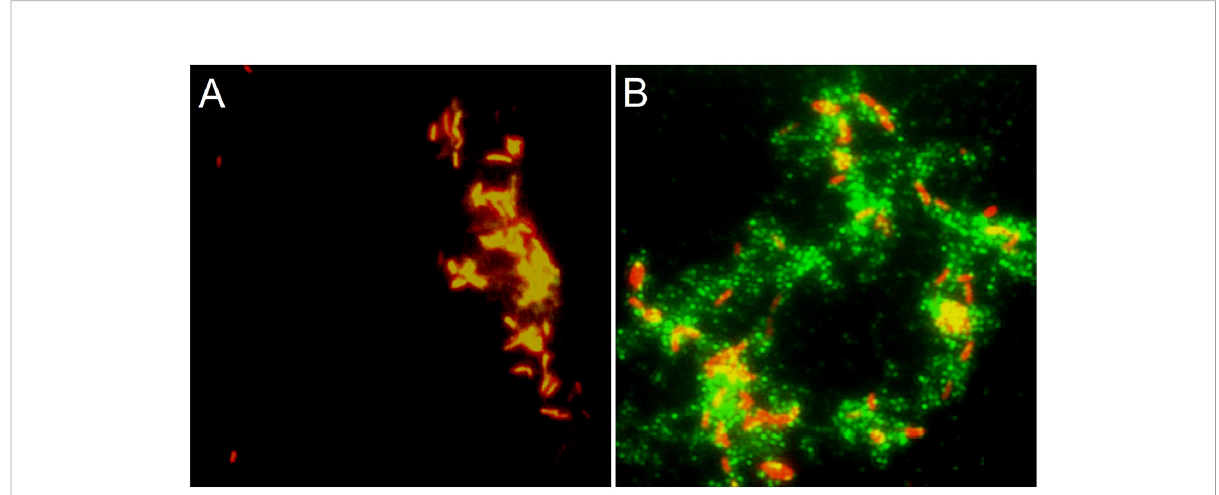
FIGURE 5 Mtb produces Flp. Immuno fl uorescence microscopy of Mtb H37Rv with anti-Flp peptide antibodies. Aliquots of stationary phase Mtb grown in standard mycobacteriological media were fi xed with formalin onto glass coverslips before being incubated with (A) pre-immune or (B) anti-Flp peptide sera. Alexa Fluor 488 anti-rabbit IgG conjugate (green) was employed to detect the primary antibody. Propidium iodide was used to label the bacterial cells (red). Samples were incubated with anti-Flp peptide antisera (B) and not with pre-immune sera (A) from the same rabbit to observe the Flp-speci fi c reaction. Magni fi cations are 1,000X.